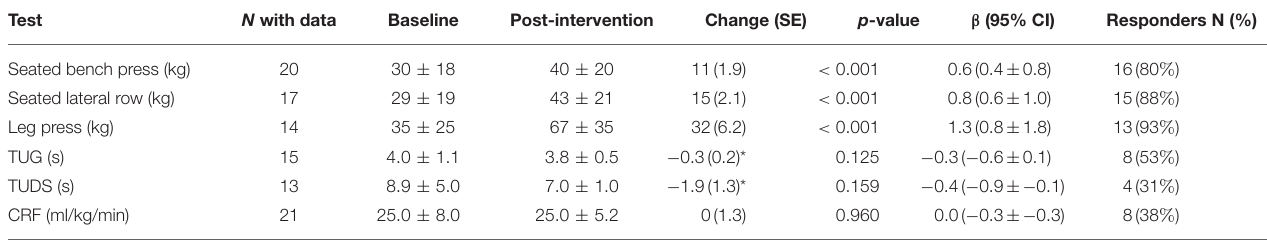
TABLE 2 | Effects of an inhospital exercise intervention on study